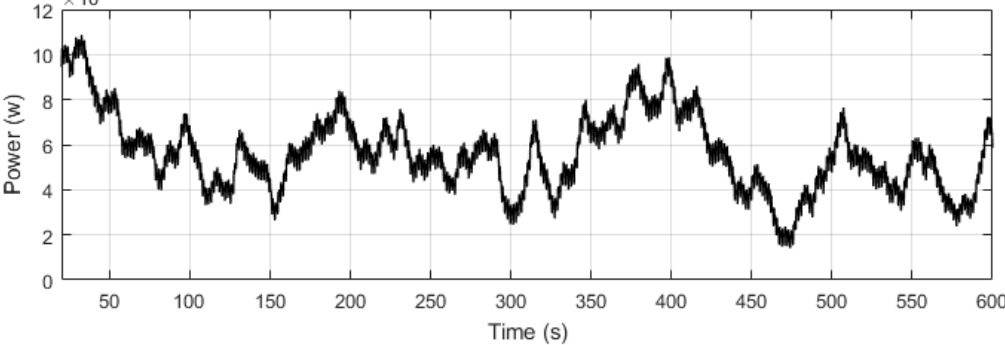
Figure 8. The initial output power of the wind farm.